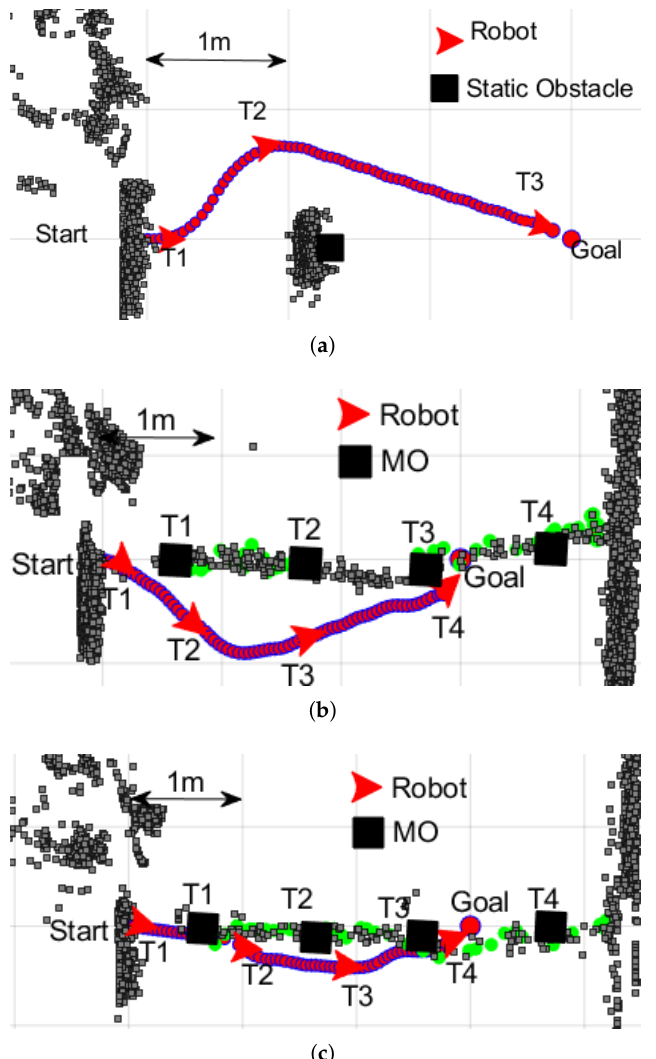
Figure 7. The robot’s paths observed in Experiment 1 with different configurations. The robot’s and obstacle’s locations at three different time instants are shown as T1–T3. ( a ) With a static obstacle (this configuration creates a local minimum for the APF method), ( b ) moving obstacle without the new FLC, and ( c ) moving obstacle with the new